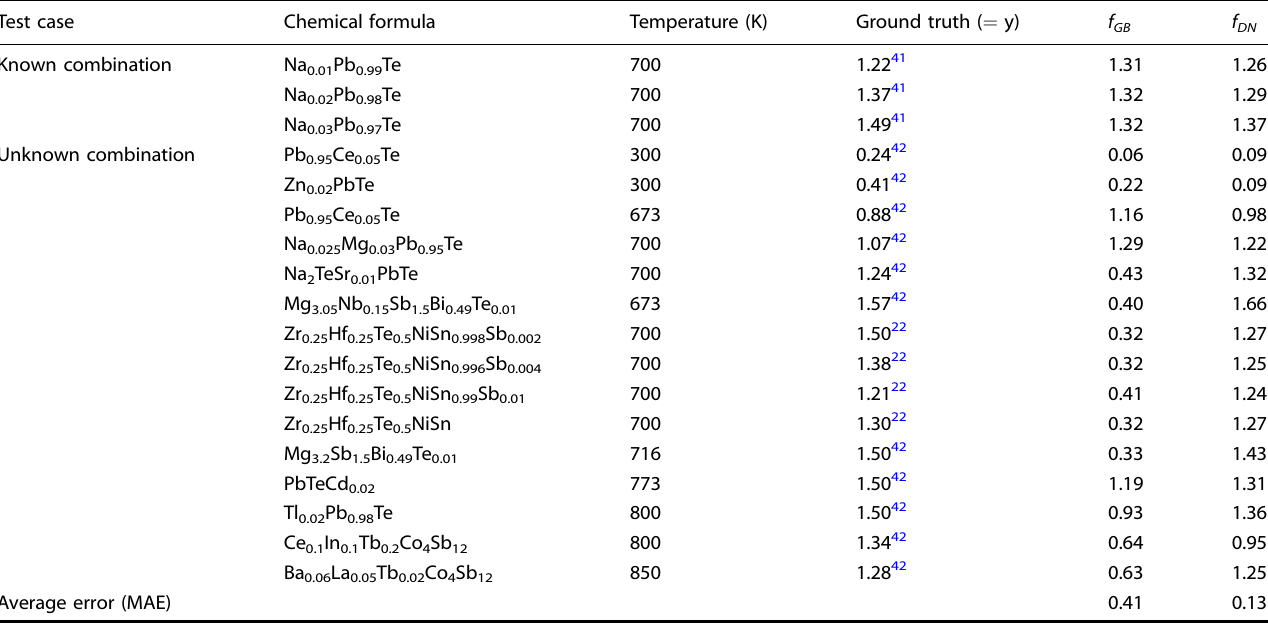
Table 3. Predicted ZTs of the machine learning algorithms for external test materials of two test cases. Test